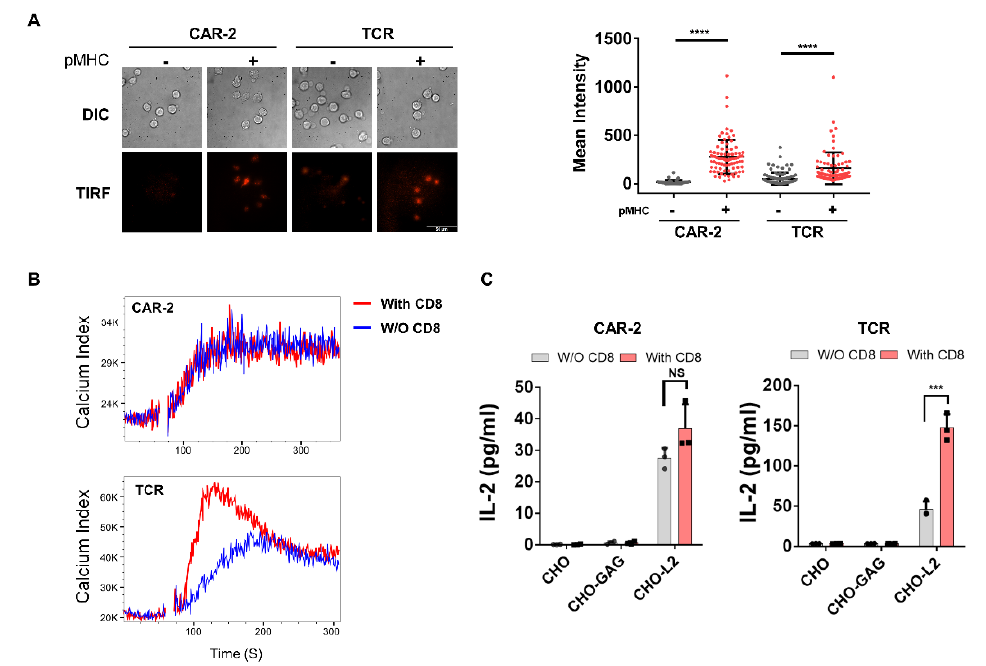
Figure 4. Interaction of TCR-like CAR CD8 coreceptor. ( A ) CD8 recruitment using TIRFM visualizing CD8 α -mCherry. Left: representative images, scale bar is at 50 µ m. Right: background-corrected mean fluorescence intensity of cell contact surface ( n > 80 cells). ( B ) Ca 2+ flux of CAR-T and TCR-T ± CD8. ( C ) CAR and TCR responsiveness ± CD8 to antigenic CHO-L2 or irrelevant CHO-GAG. Data are representative of at least three independent experiments, plotted as mean ± SD of technical triplicates. *** p < 0.001, **** p < 0.0001; NS: not significant at p > 0.05, by Student’s t -test.